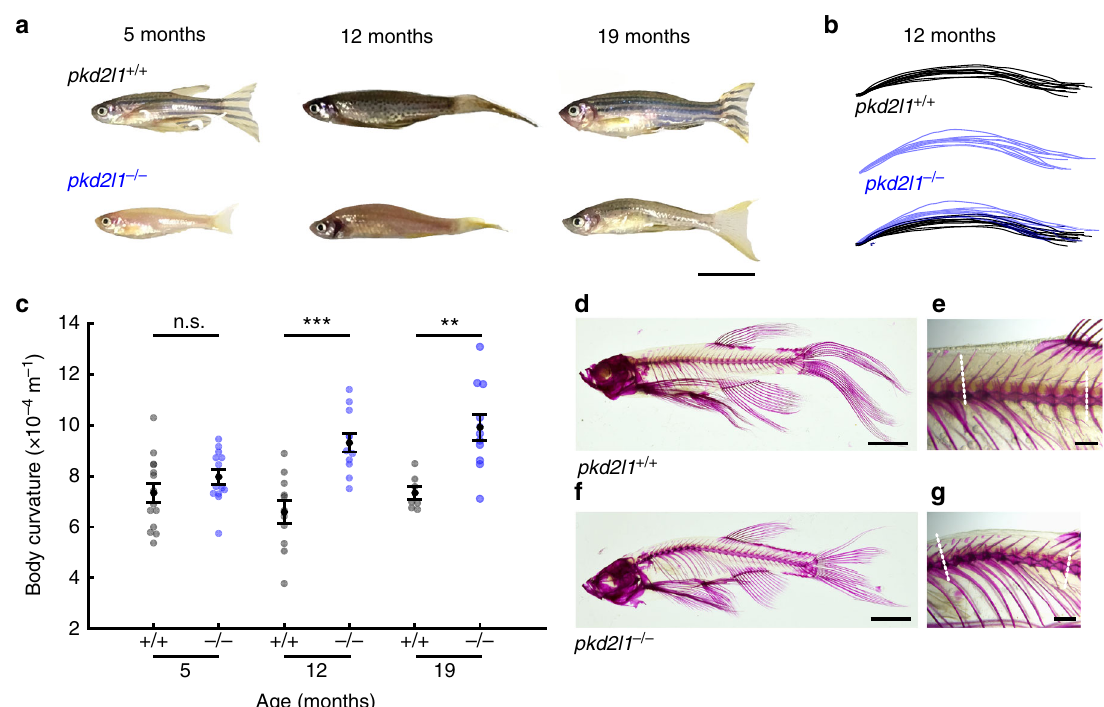
Fig. 5 Pkd2l1 is necessary to maintain a straight spine. a Representative pkd2l1 + / + and sibling pkd21 − / − adult zebra fi sh at adult stages. Scale: 1 cm. b Body curvature traces from pkd2l1 + / + (black) and pkd2l1 − / − (blue) adults at 12 months ( n = 11 pkd21 + / + , n = 11 pkd2l1 − / − ). c Quanti fi cation of body axis curvature. Each point represents one fi sh. Error bars represent s.e.m. (5 months: n = 14 pkd2l1 + / + , n = 13 pkd2l1 − / − , p = 0.02; 12 months: n = 11 pkd2l1 + / + , n = 11 pkd2l1 − / − , p = 1.42 × 10 ‒ 4 ; 19 months: n = 7 pkd2l1 + / + , n = 11 pkd2l1 − / − , p = 1.5 × 10 ‒ 3 ; two-sample t test). d Alizarin red staining of bones of an adult pkd2l1 + / + fi sh at 20 months of age, showing little to no spinal kyphosis. Scale: 5 mm. e High-magni fi cation image of the precaudal region of the pkd2l1 + / + spine. Dotted lines indicate vectors used to calculate the Cobb angle. Scale: 1 mm. f Alizarin red staining of an adult pkd2l1 − / − fi sh. Note the kyphosis in the precaudal region. Scale: 5 mm. g High-magni fi cation image reveals pronounced kyphosis, no torsion is evident (see Supplementary Table 2 for Cobb angles). Scale: 1